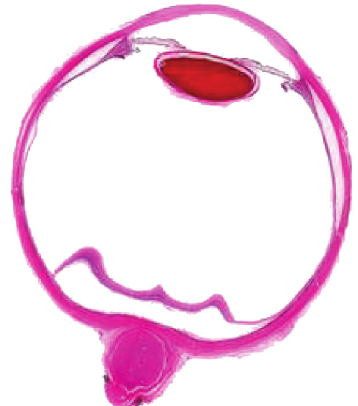
Figure 3: The image used to extract section features of the human eye.